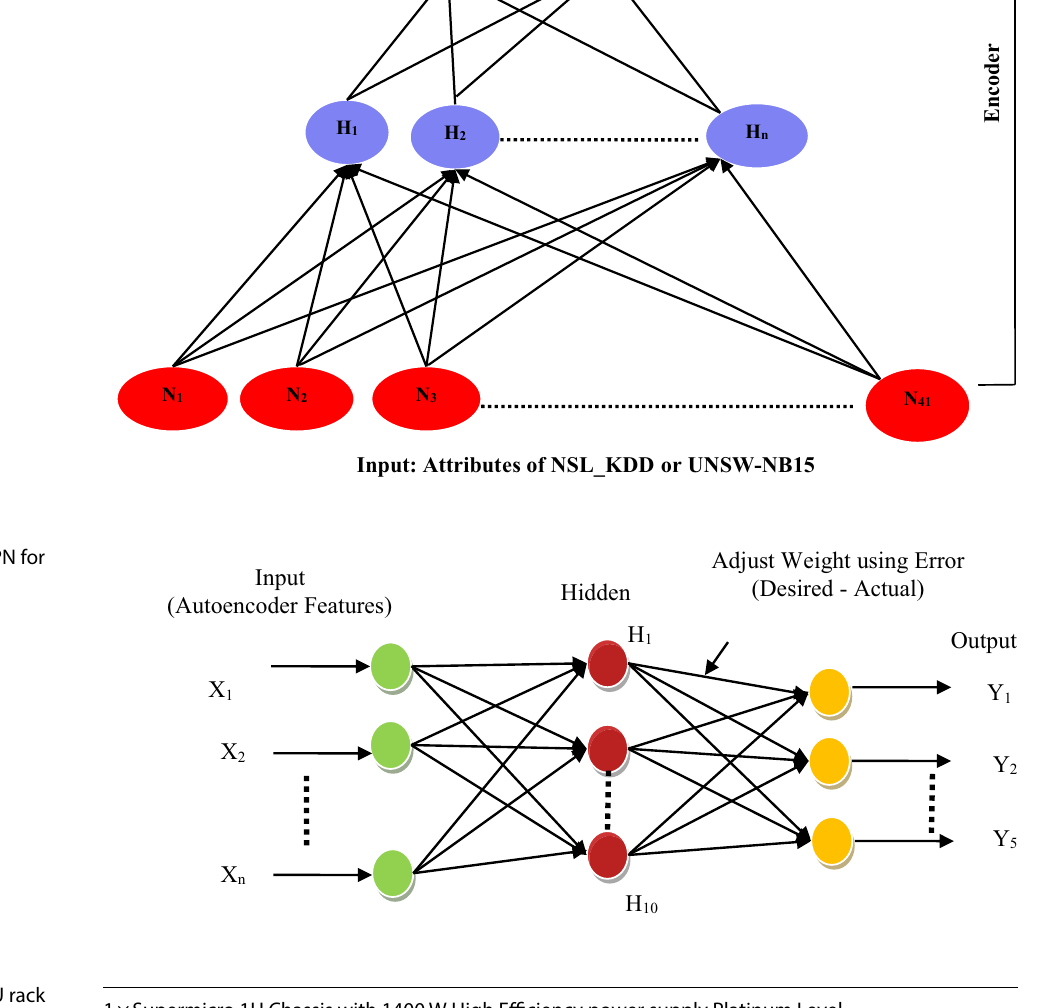
Table 1 Boston X86-GPU rack server